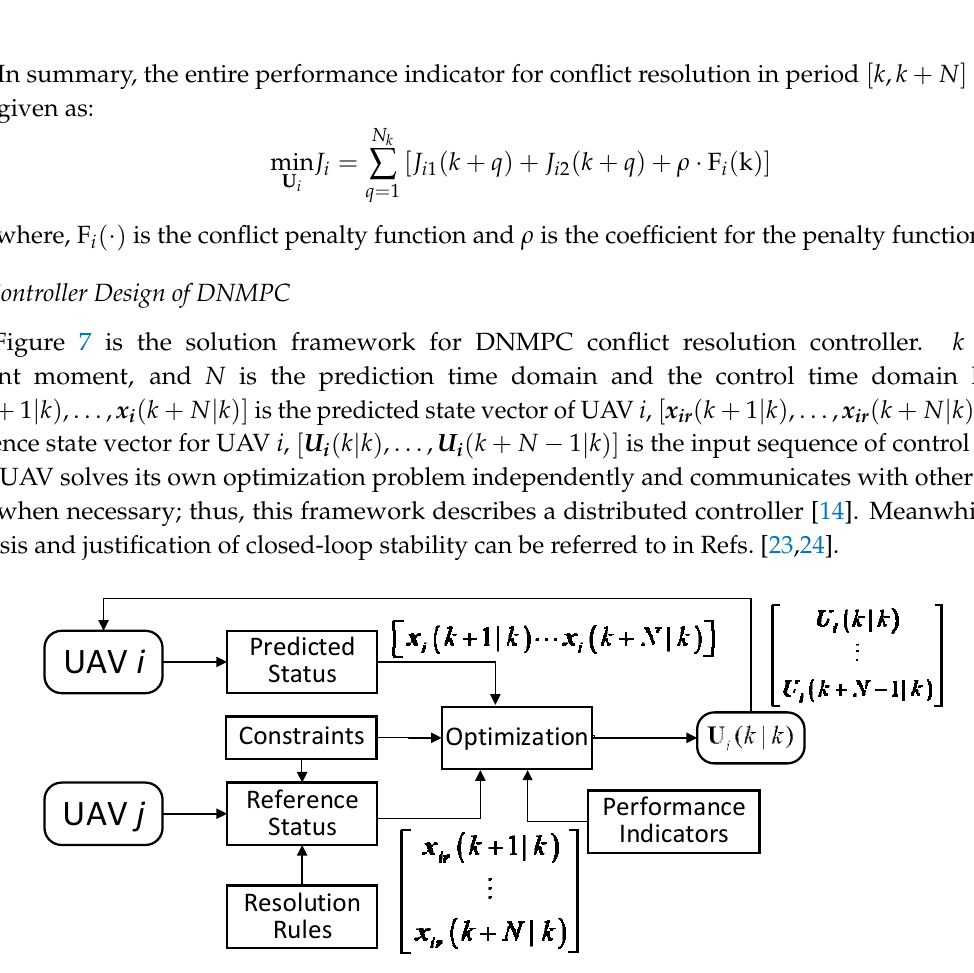
Figure 7. Solution framework for DNMPC.